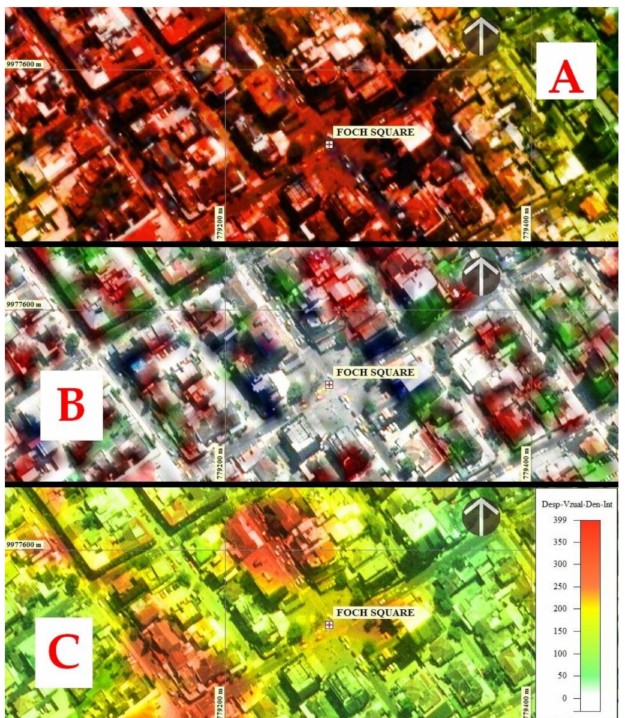
Figure 11. Concordance between the methods applied to determine exposure-vulnerability in Foch Square, considering INSAR-space syntax and the seismic risk study prepared by Parra [9]. ( A ) Foch Square and its surroundings. ( B ) Very high to high seismic vulnerability. ( C ) Busiest places in the